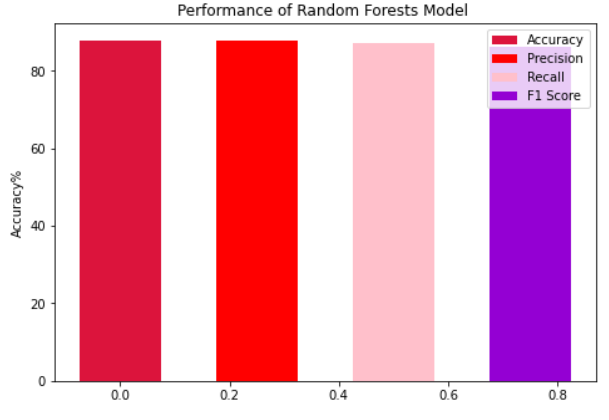
Figure 2. Performance Random Forests